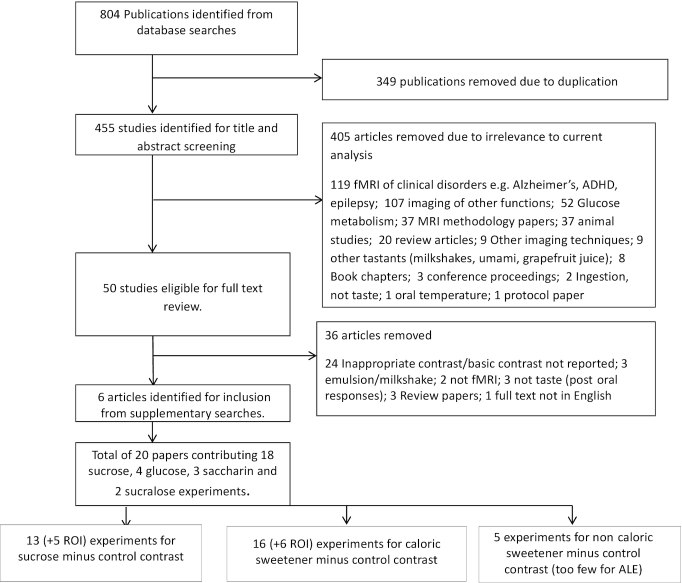
Flow diagram of study selection from systematic review of fMRI studies assessing sweet taste in human adults. ADHD, attention deficit hyperactivity disorder; ALE, activation likelihood estimation; ROI, region of interest.